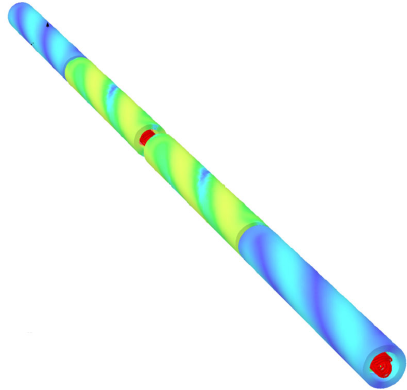
FIG. 4. OPERA model of RHIC four-helix snakes and